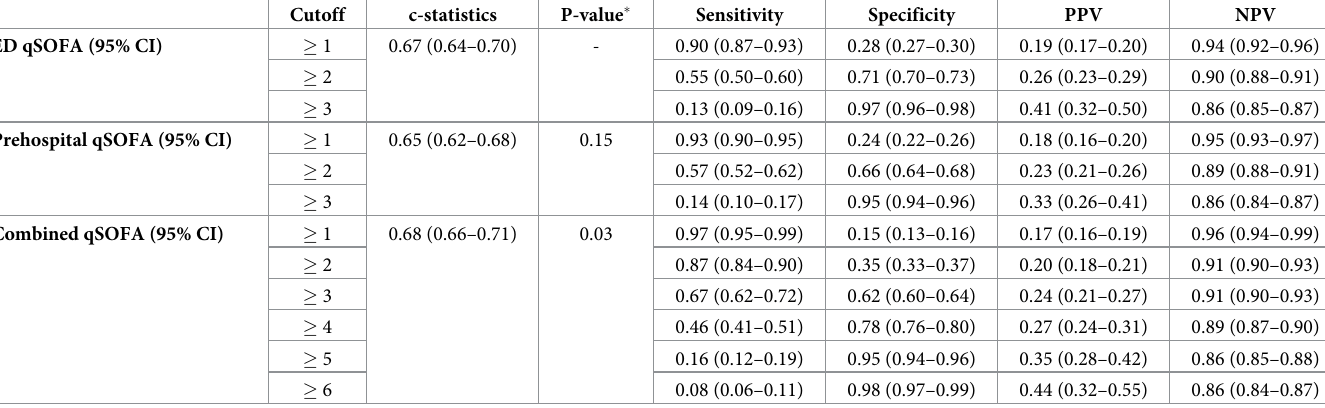
Table 3. Predictive abilities of the ED qSOFA, prehospital qSOFA, and combined qSOFA for sepsis.